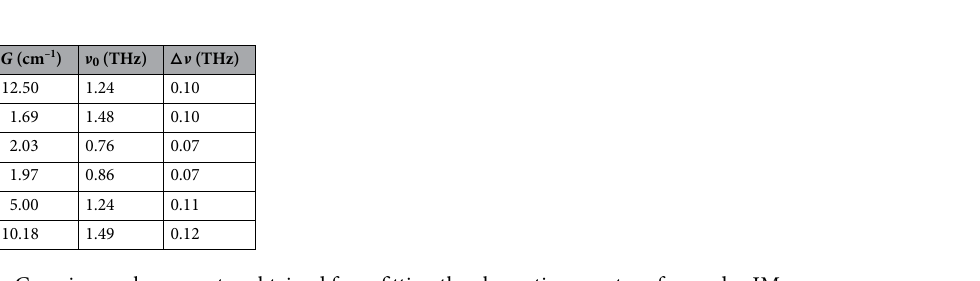
Table 1. Gaussian peak parameter obtained from fitting the absorption spectra of γ - and α -IM.